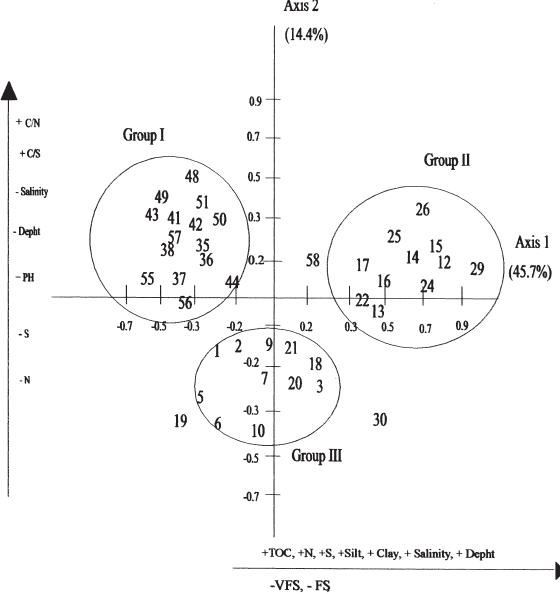
F IG . 8. – PCA ordination diagram of sampling based on the select- ed variables measured. The three main groups formed are shown (Group I, II and